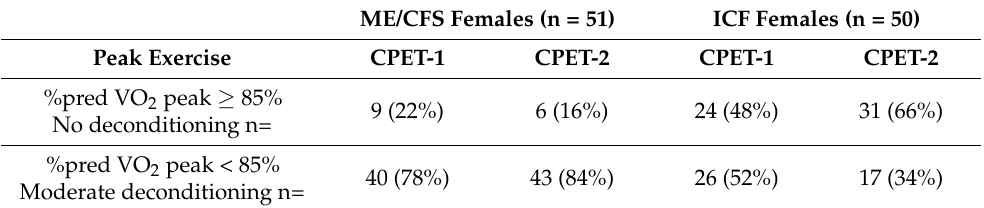
Table 4. CPET-1 and CPET-2 variables for female ME/CFS patients (left side) and female ICF patients (right side) with respect to “fitness”/